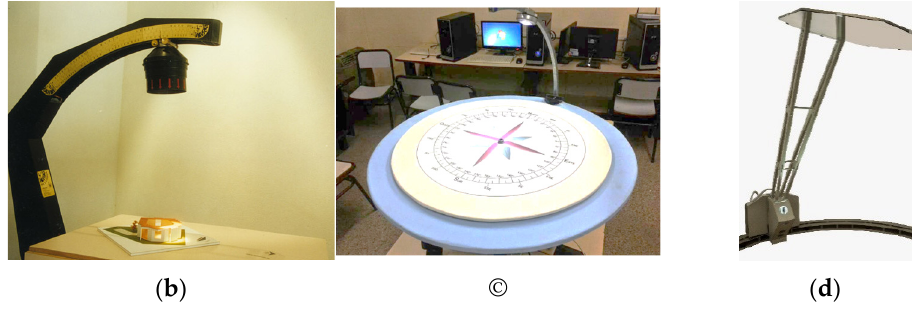
Figure 11. ( a ) Heliodon proposed by Szokolay in 2011, ( b ) Prototype built by Mendoza in 2014, ( c ) Heliodon built by Montoya in 2014, ( d ) Tulip Heliodon designed by Betanit company.